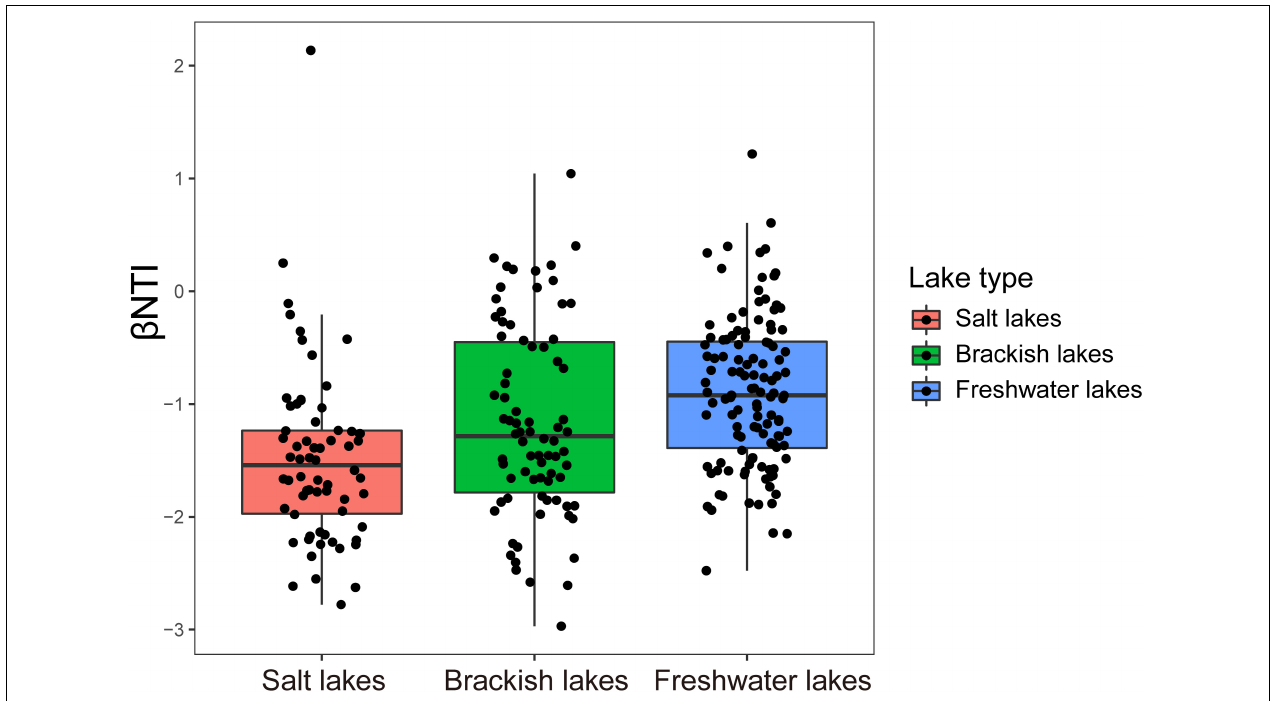
FIGURE 7 | Distribution patterns of β NTI values among lakes with different salinity gradients on the Inner Mongolia Plateau.